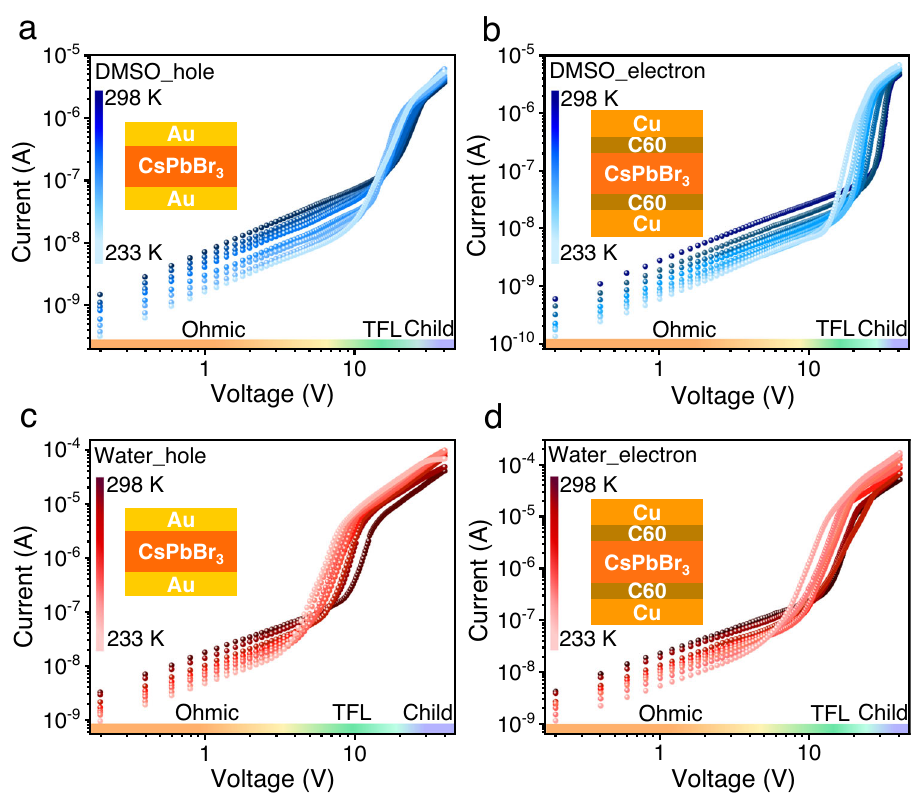
Fig. 3 Electrical properties determined by SCLC. Temperature-dependent J – V characteristics of a hole-only and b electron-only devices of CsPbBr 3 SCs grown in DMSO, and c hole-only and b electron-only devices of CsPbBr 3 SCs grown in water. A linear ohmic regime (yellow) is followed by the trap- fi lled regime, marked by a steep increase in current (green), then followed with Child ’ s regime (purple). The insets depict the device